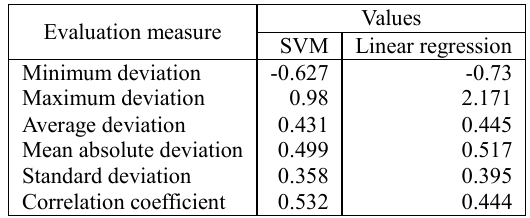
Table 3. Comparison between SVM and linear